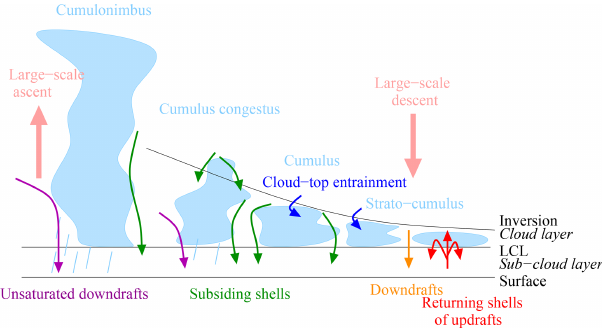
Figure 1. Schematics showing the different types of clouds and mixing processes as a function of the large-scale